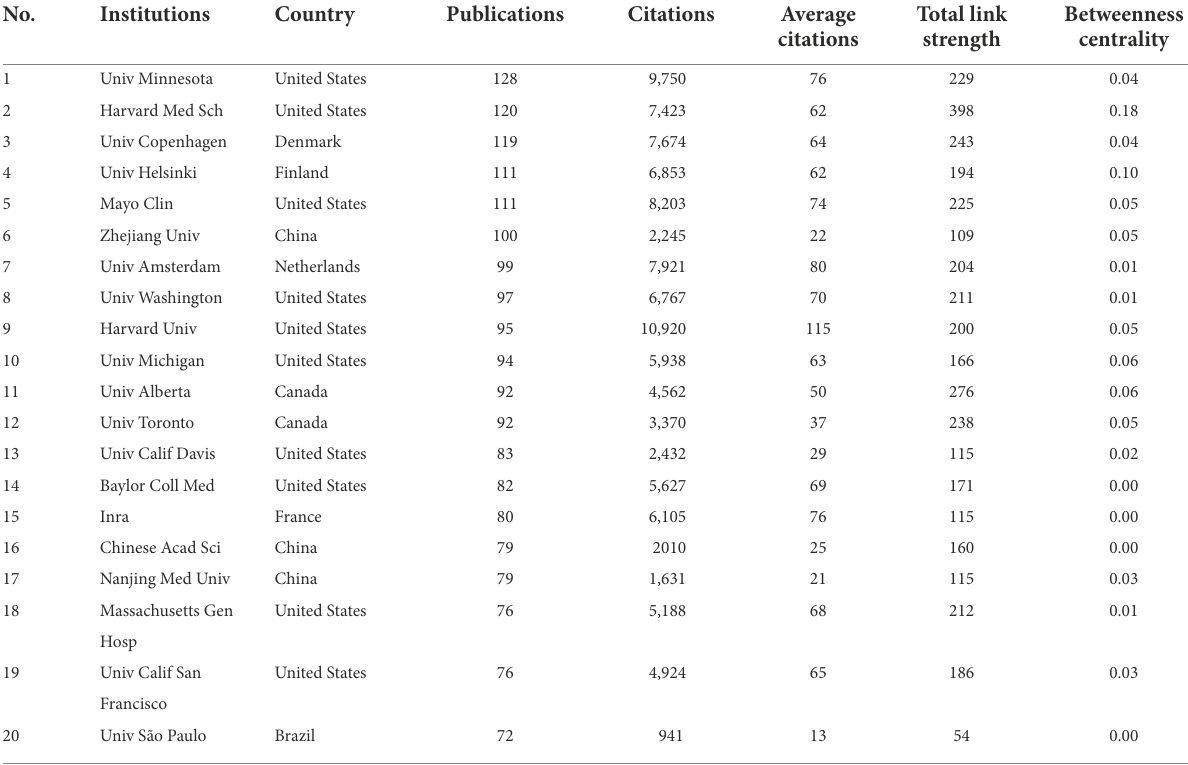
TABLE 2 The characteristics of the top 20 institutions based on